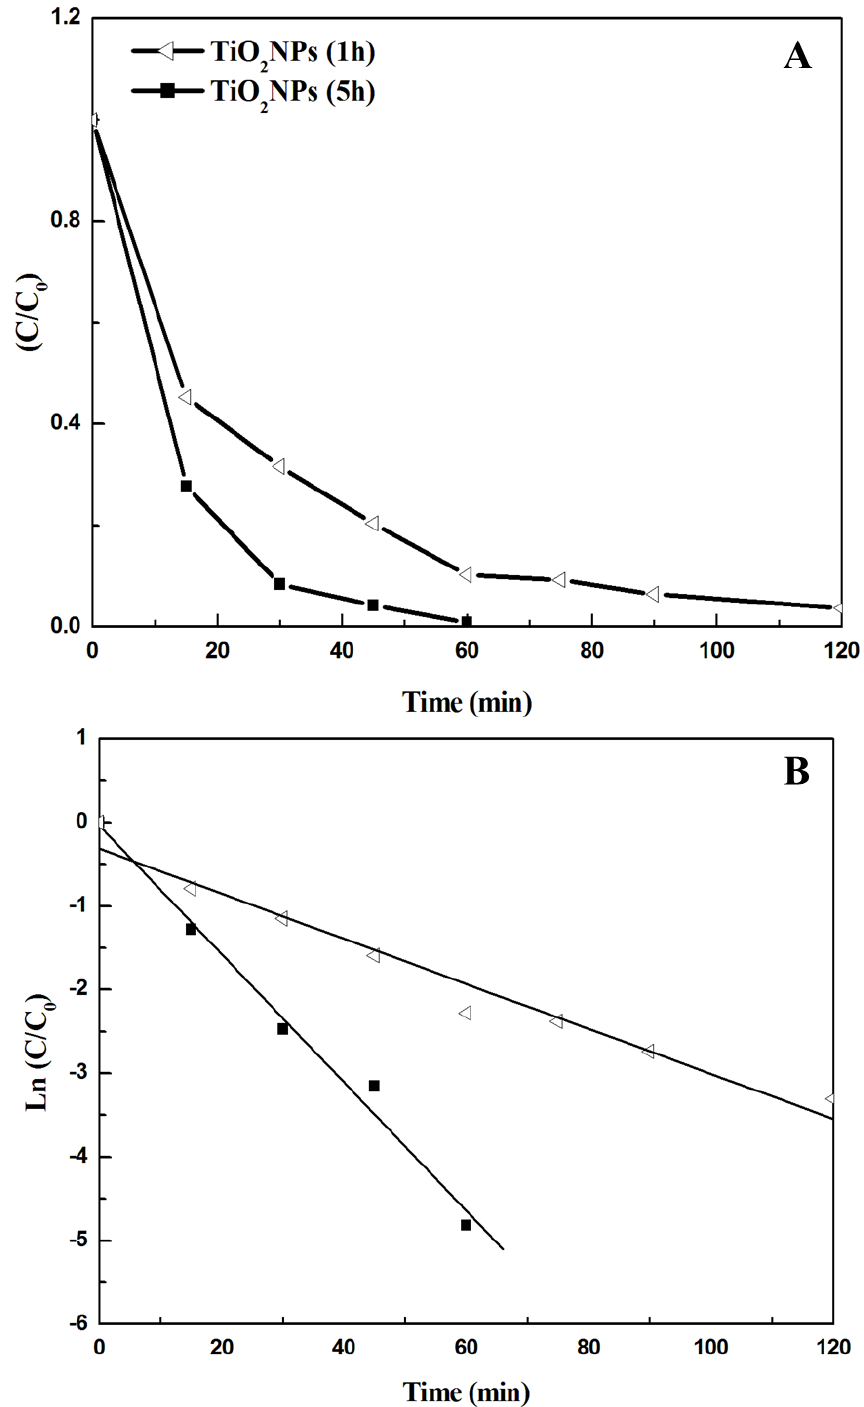
Figure 12. Photocatalytic degradation of RR180 ofTiO 2 nanoparticles under UV light irradiation ( A ) and first order linear transforms of disappearance of RR180 ( B ). ( A ) and first order linear transforms of disappearance of RR180 ( B